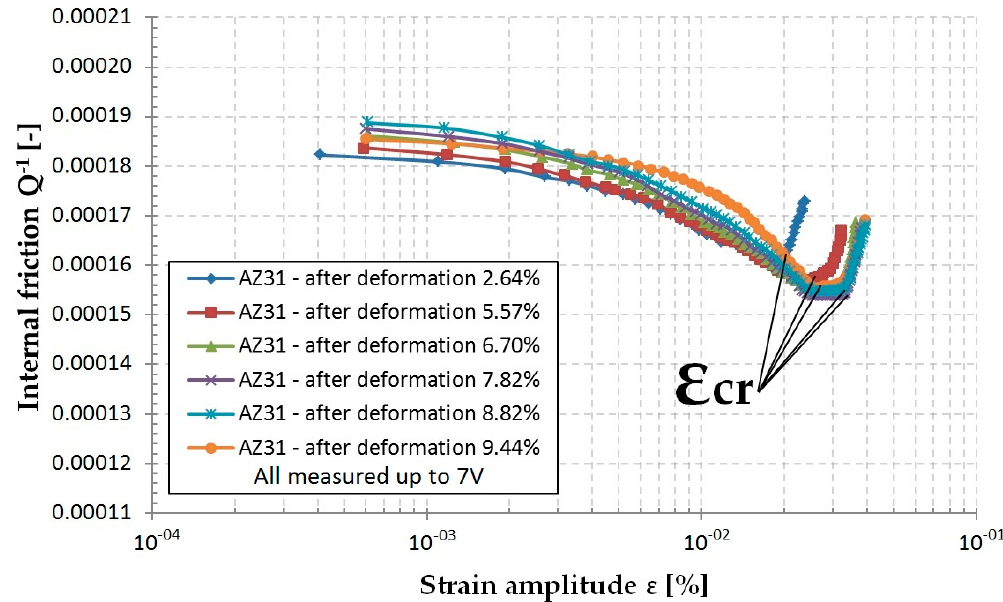
Figure 12. Amplitude dependent internal friction measured for the predeformed samples of AZ31.